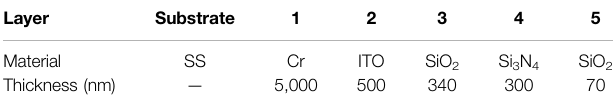
TABLE 1 | The material selection and thickness setup assigned for each layer of the proposed fi lm after genetic algorithm optimization process.